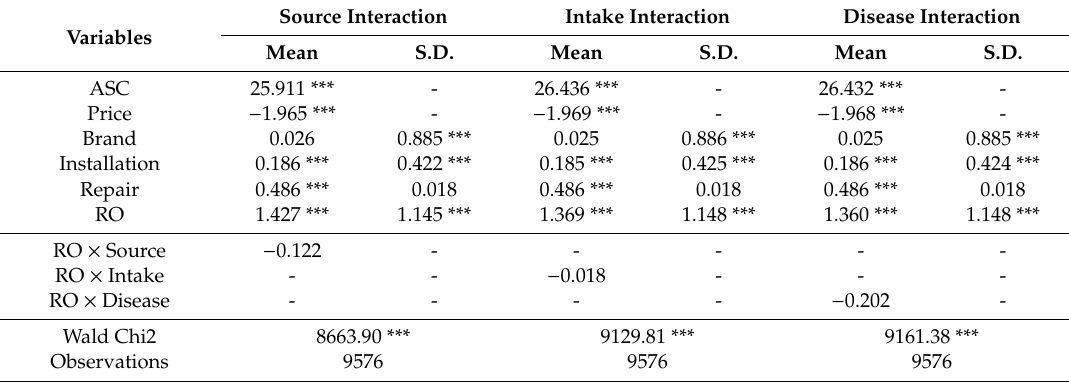
Table 11. The robustness check results of scientific knowledge e ff